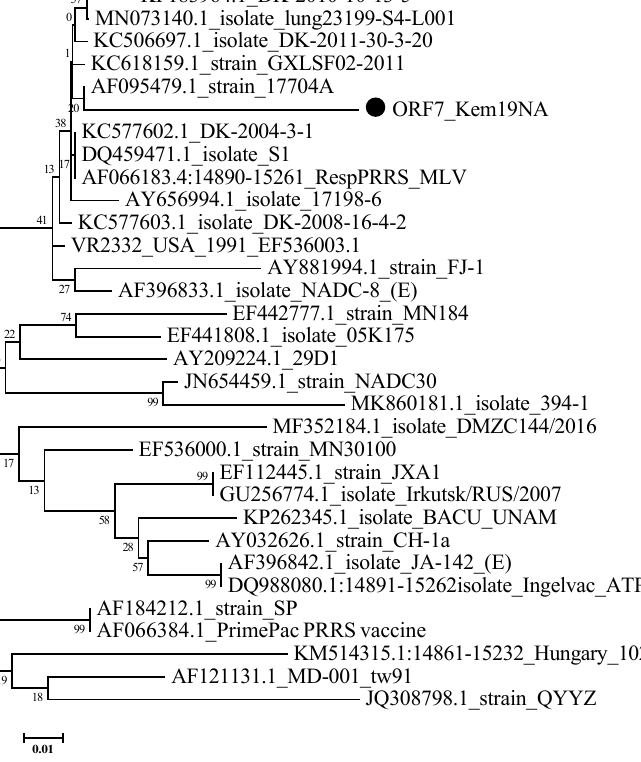
Figure 4. Phylogenetic trees of PRRSV2 strains based on partial ORF7 nucleotide sequences. Bootstrap confidence limits are presented at each node. The Kem19NA strain is designated by a circle ( • ). Strains are designated in the following format: GenBank accession number_ name. Further genetic analysis (Figure 5a) revealed that Kem19NA had an amino acid insertion of lysine (K) at position 47 in the nuclear localization signal ( NLS ) sequence of the N protein. Similar amino